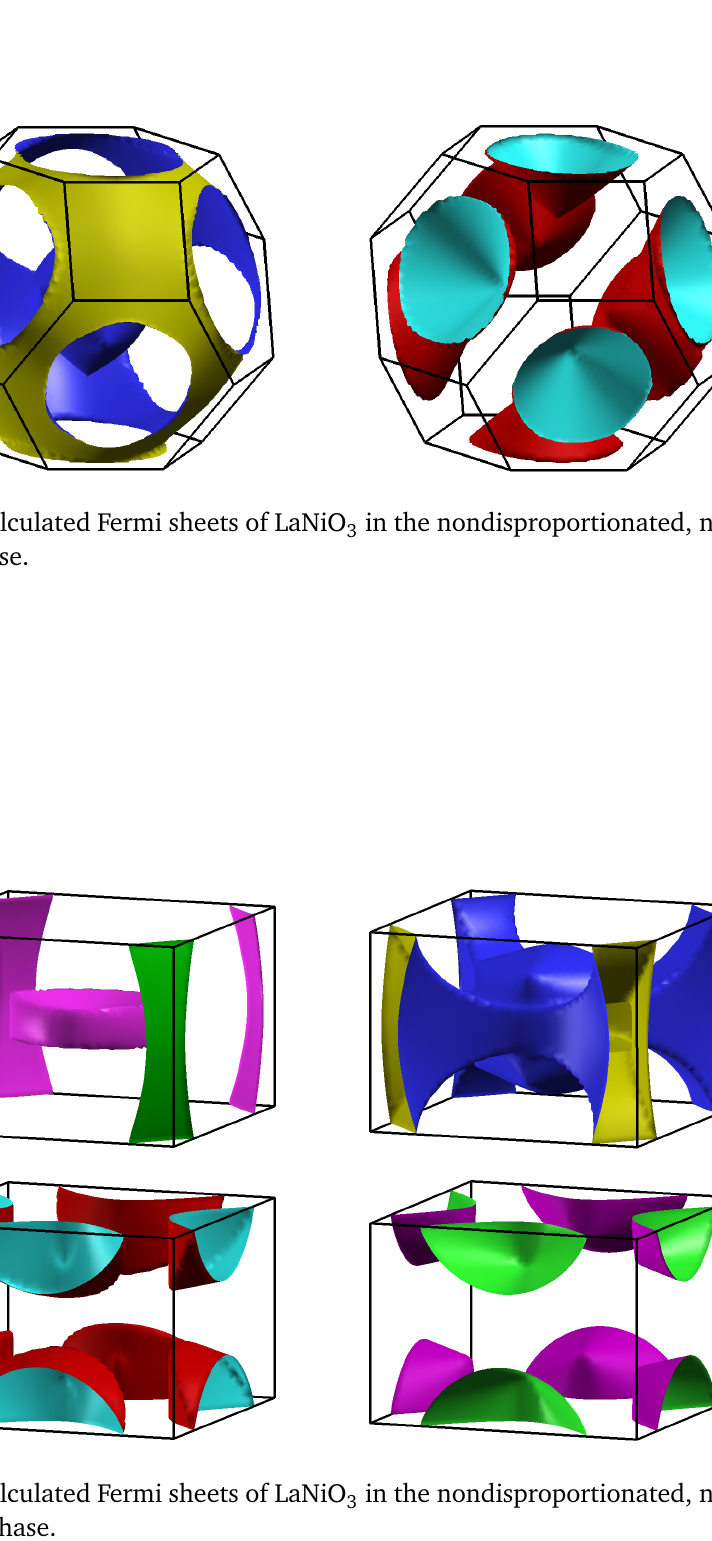
in the nondisproportionated, nonmag- 3